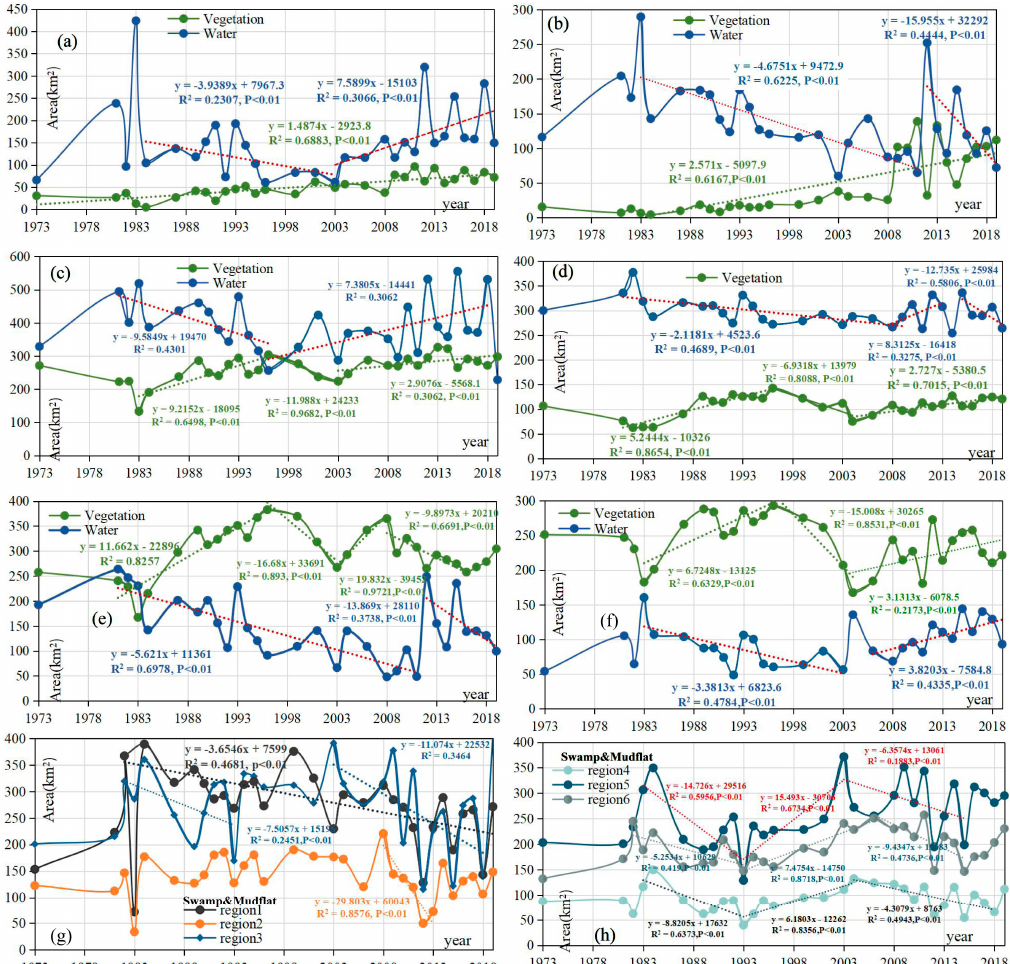
Figure 6. Long-term trends and model of vegetation and water from 1973–2019 in Poyang Lake: ( a ) region 1, ( b ) region 2, ( c ) region 3, ( d ) region 4, ( e ) region 5, and ( f ) region 6 between 1973 and 2019. swamp and mudflat trends and modes of ( g ) regions 1, 2, and 3 and ( h ) regions 4, 5, and 6.